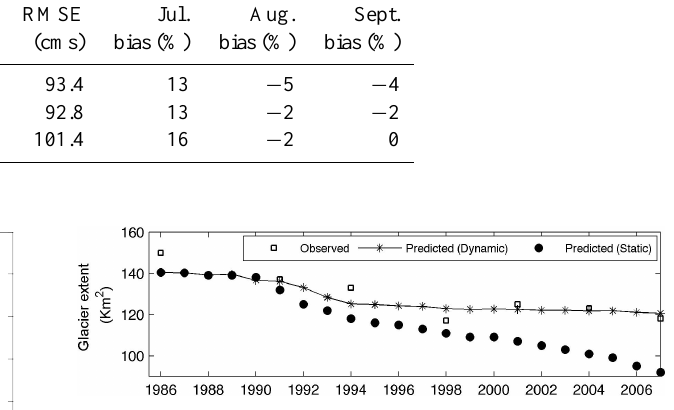
Fig. 11. Comparison of monthly model-predicted ice cover extent with Landsat-derived ice cover for years when the cloud-free im- ages were available at the end of melting season for the study do- main. The dates of acquisition of Landsat images are given in Ta- ble